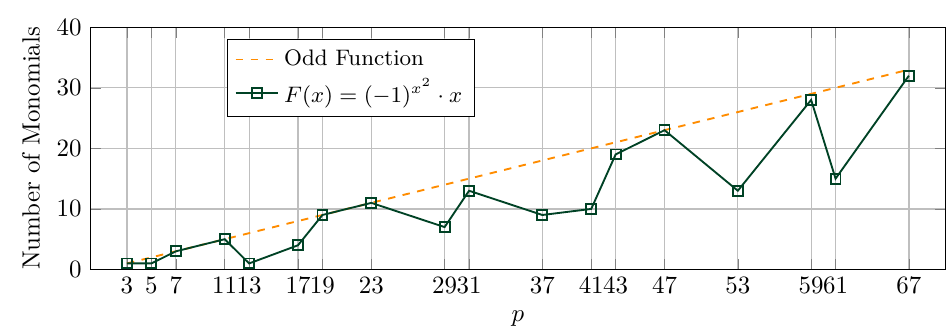
Figure 6: Comparison of the number of monomials for a generic odd function and for F ( x ) = ( − 1) x 2 · x for several values of p